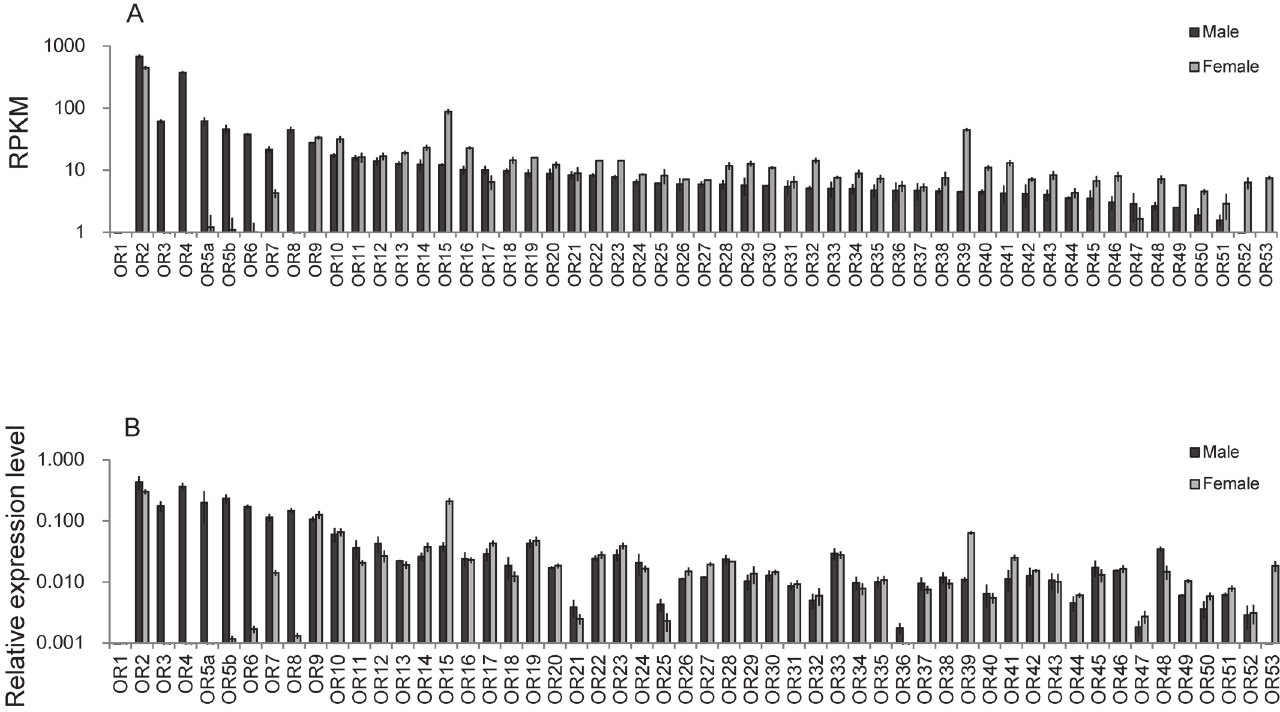
Fig 2. Expression level of candidate odorant receptors in adult antennae. (A) Estimated by read mapping. (B) Estimated by qRT-PCR. Error bars represent standard error calculated from the results of three biological